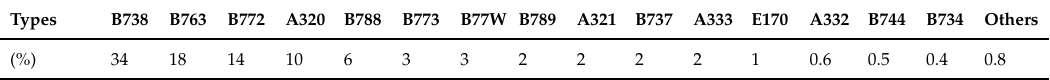
Table 1. Percentages of aircraft types among all aircraft arrivals.